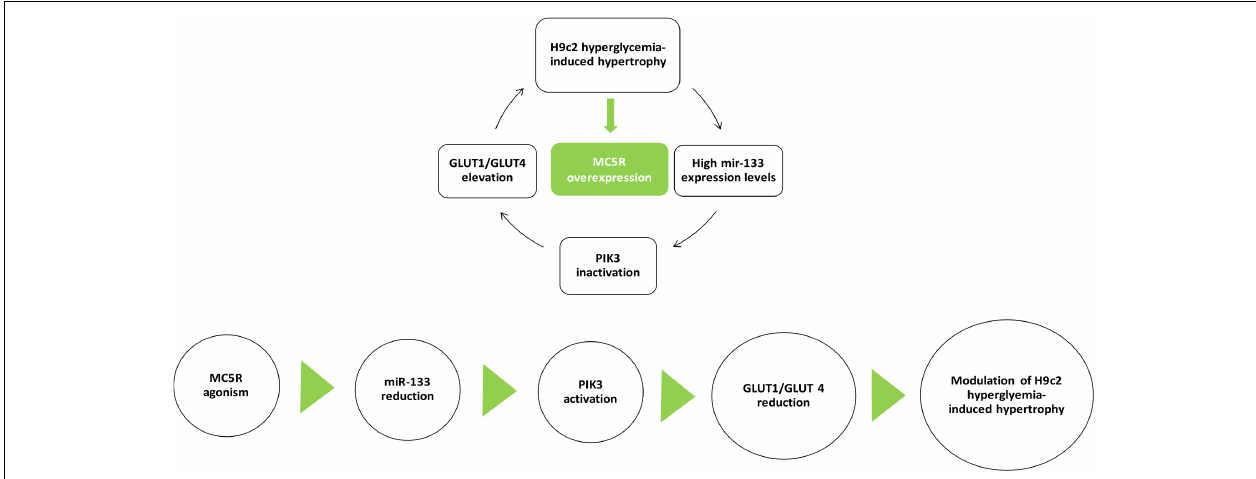
FIGURE 8 | MC5R signaling in cardiac hypertrophy induced by high glucose. H9c2 hypertrophy induced by hyperglycemia is characterized by increased miR-133a levels, leading to PI3K inactivation and GLUT1/GLUT4 elevation. Here, we show for the first time an up-regulation of MC5R, involved in glucose-uptake, as a defensive and anti-hypertrophic response to the high-glucose induced damage. MC5R agonism reduced H9c2 hypertrophic markers by decreasing miR-133a levels, consequently restoring PI3K activity and GLUT1/GLUT4 ratio.